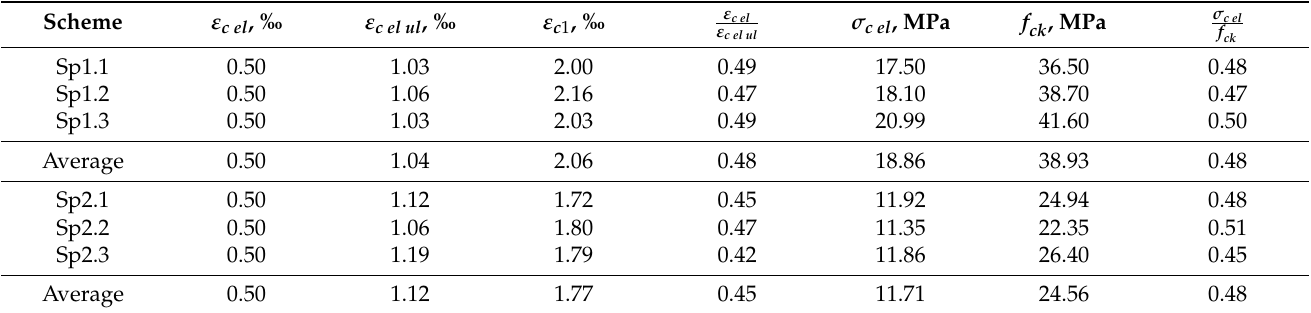
Table 2. Experimental values of the σ c − ε c diagram ascending branch parameters.